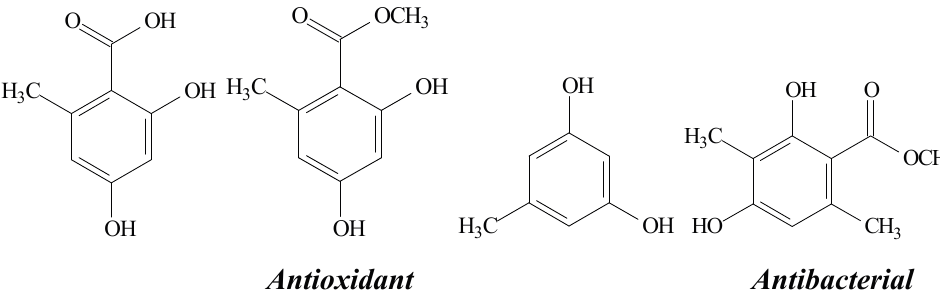
Figure 11. Structures and biological activities of orsellinic acid, methyl orsellinate, orcinol and methyl- β -orcinolcarboxylate,